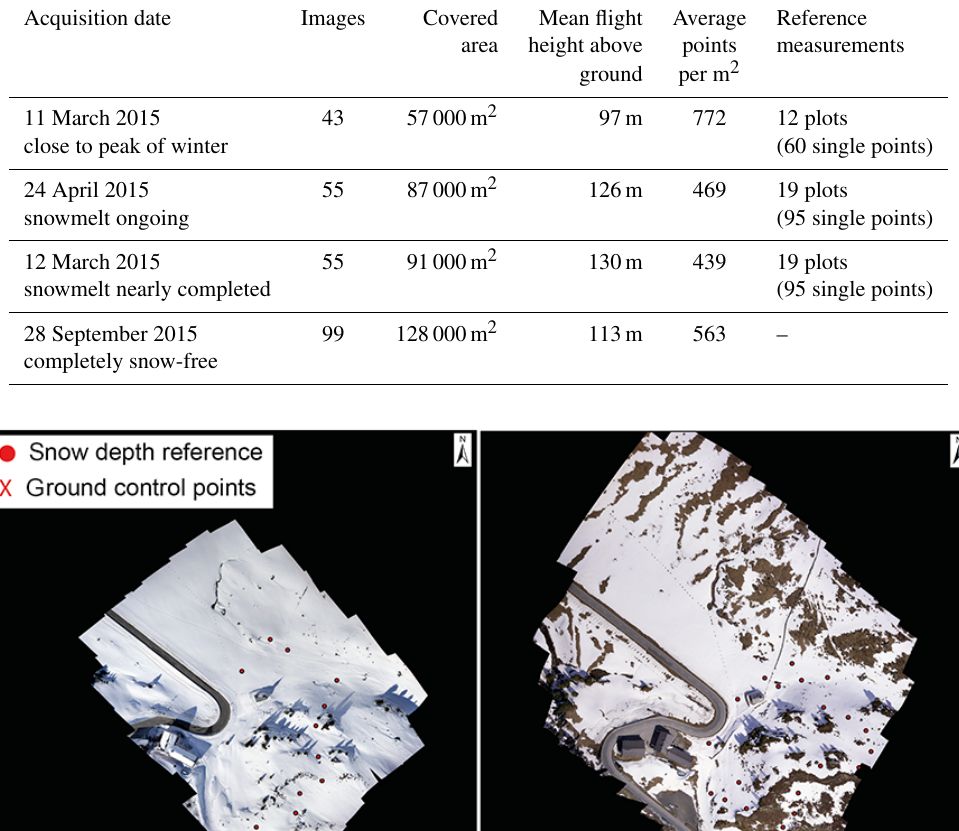
Table 2. Data acquisition parameters for Tschuggen.